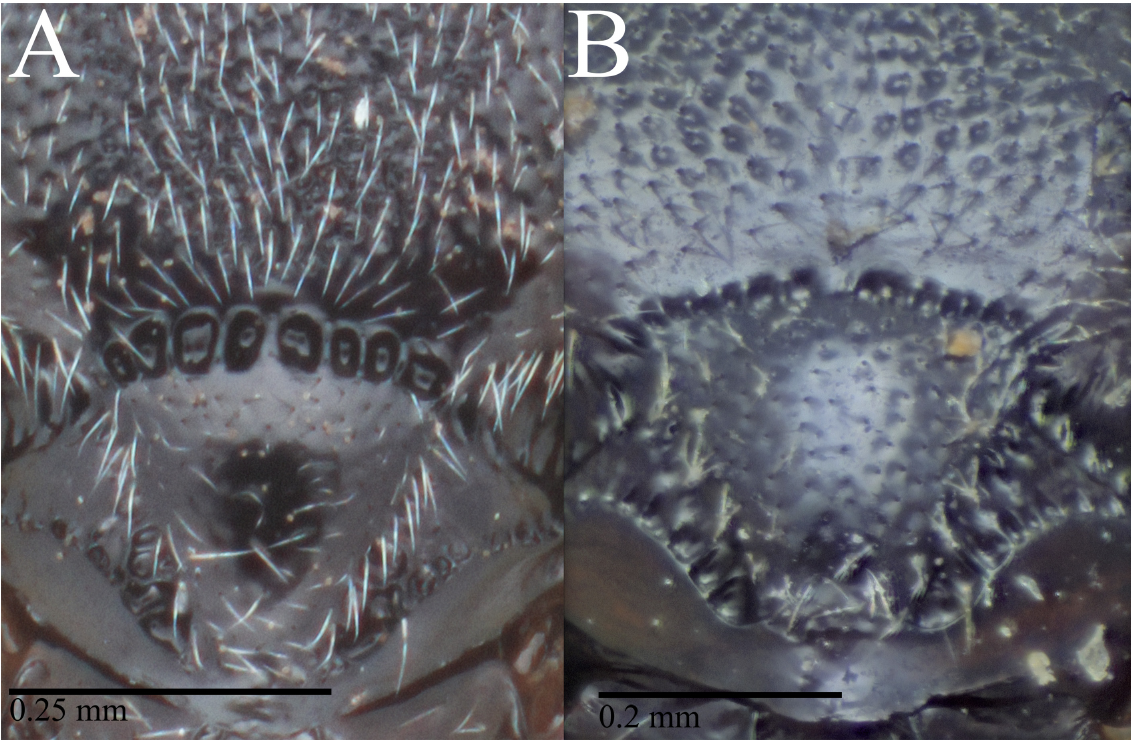
Fig. 12. Scutellar disk, scutellar sulcus and partial anteromesoscutum. A . Cotesia medusae sp. nov. (paratype, QM T246705). B . C. australiensis (Ashmead, 1900) (ANIC 32